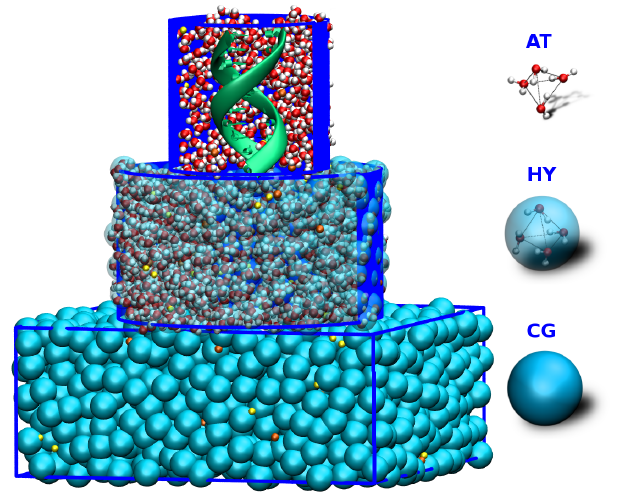
Figure 2. Schematic depiction of a simulation box with an atomistic DNA in the center surrounded by MARTINI salt solution. Two levels of resolution are used for solvent molecules. AT level of resolution is used for proximal solvent molecules, within a certain radius from the DNA’s center of mass. The distal water molecules are represented as blue MARTINI CG beads, where one CG bead corresponds to four water molecules. Na + and Cl − ions are shown in orange and yellow, respectively. Adapted from Ref.